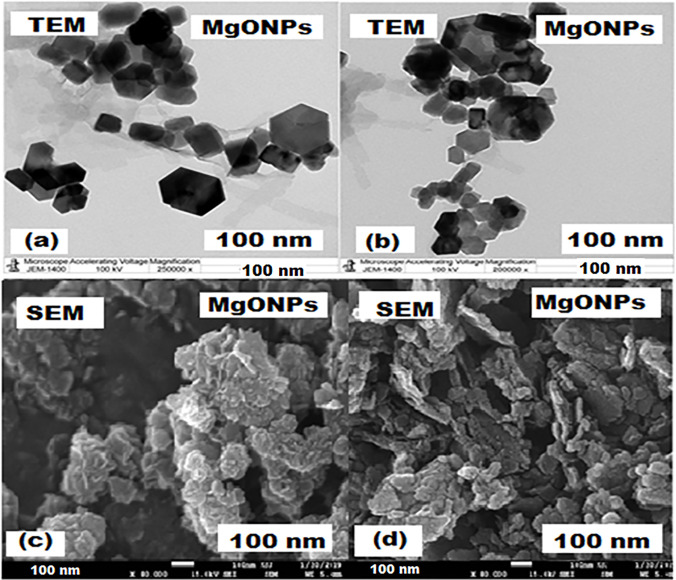
(a and b), (c and d) are the TEM and SEM images of MgONPs synthesized by S.costus (Qustal hindi and Qustal bahri) biomasses, respectively.